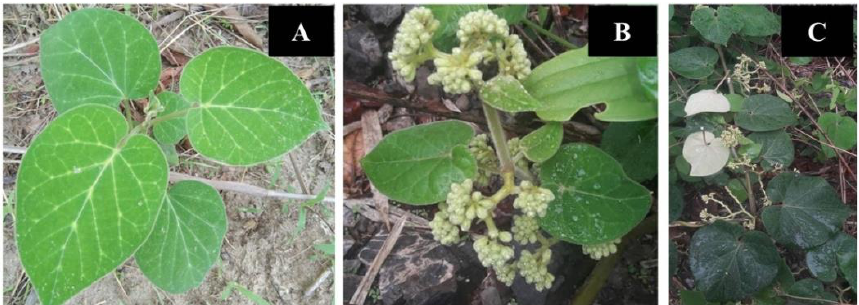
Figure 1. ( A ) Leaf, ( B ) inflorescence, and ( C ) aerial part of Marsdenia tenacissima